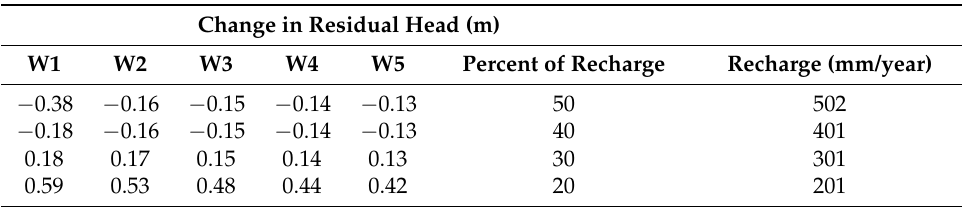
Table 4. Change in head at piezometers W1 to W5 due to change in recharge (Scenario 5) in comparison to the baseline calibrated model (recharge = 351 mm/year (35 percent)).